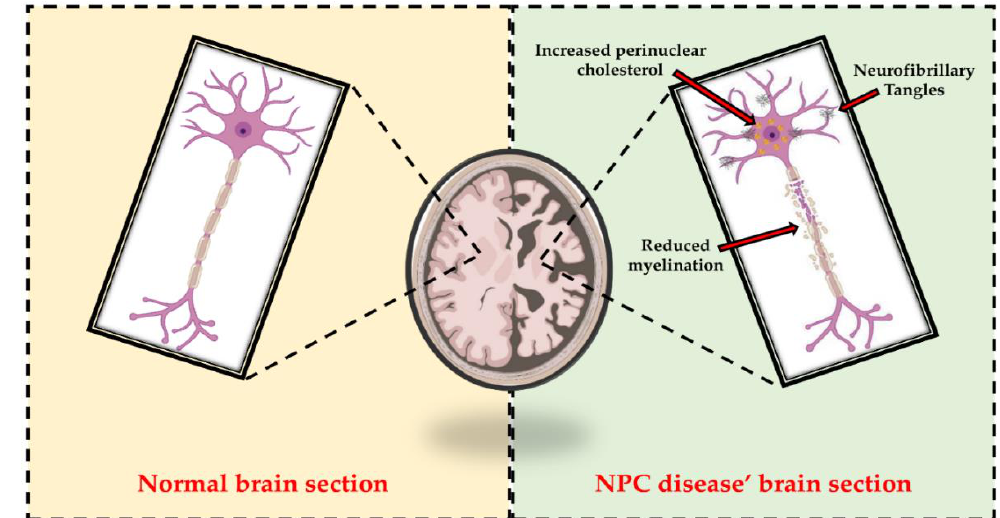
Figure 2. Representative comparison between normal brain section and NPC disease’ brain section. As highlighted in the right panel, alterations in cholesterol homeostasis are associated with disruption of brain function and the onset of neurodegeneration. In fact, increased perinuclear cholesterol, reduced myelination, and neurofibrillary tangles (NFT) accumulation are among the hallmarks of NPC patients’ neurons.